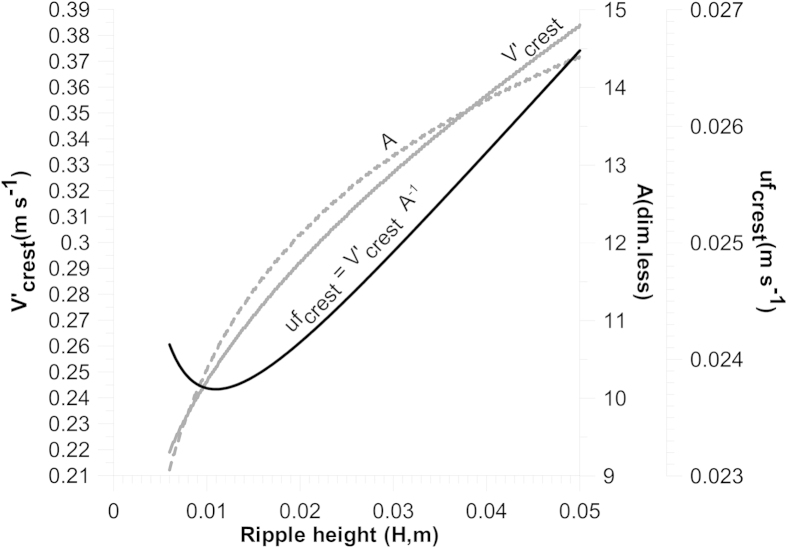
Model prediction (see text) of the terms in Equation (3) as a function of ripple height.The results are derived on the basis of data from13, corresponding to run 31 with 0.19 mm sand in an 8-foot-wide flume (L = 0.18 m and H = 0.012 m). Full gray line: mean velocity in the virtual boundary layer above the crest (V′crest); dashed gray line: A; and full black line: ufcrest. Flow properties and grain size are kept constant, whereas the ripple height increases from values below the measured size to above it.